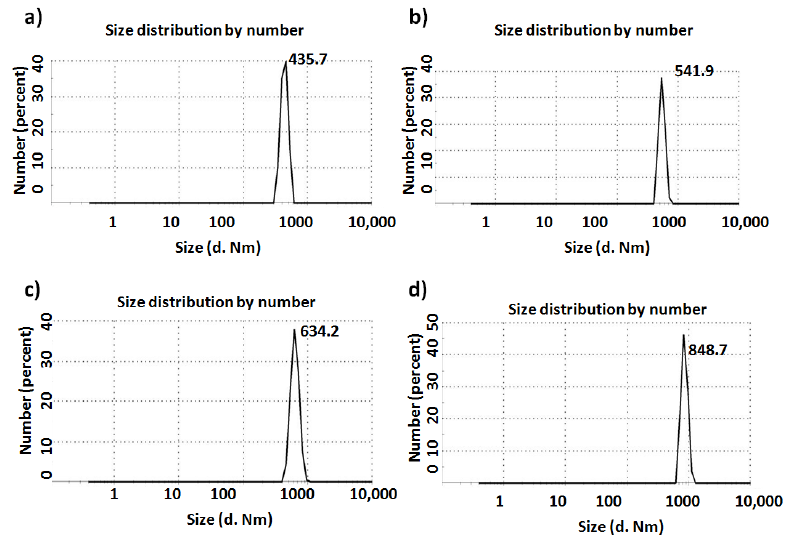
Figure 6. Particle size of ( a ) BGT0, ( b ) BGT5, ( c ) BGT7.5 and ( d ) BGT10 determined by Zetasizer. The zeta potential of the fabricated glasses before and after TiO 2 inclusion in the glass network is shown in Figure 7. It is worth highlighting that the presence of Ti did not significantly change the surface charge of the fabricated glasses. The zeta potential values were generally negative; the negative charge on the surface of any biomaterial enhances its interactions with biological systems, especially with cells, as previously reported [34,35].